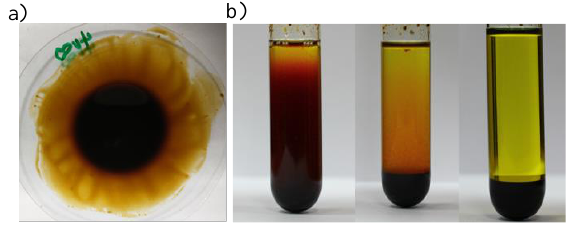
Fig. 1. On the left, a mixture of tire pyrolysis oil with butanol, on the right, a mixture of biomass pyrolysis oil and gasoline